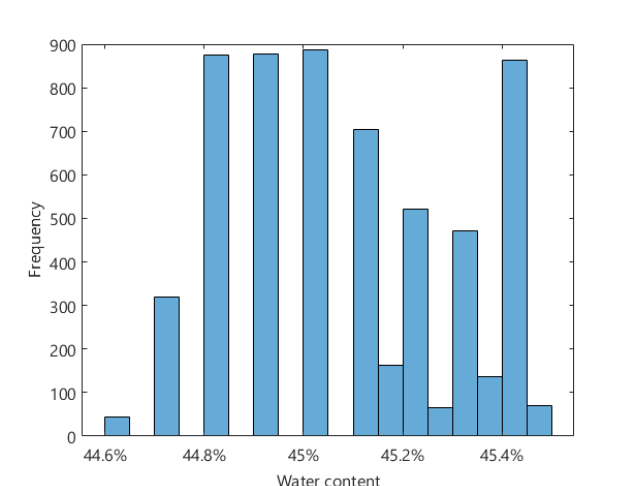
Figure 7. Monitoring data of water content.